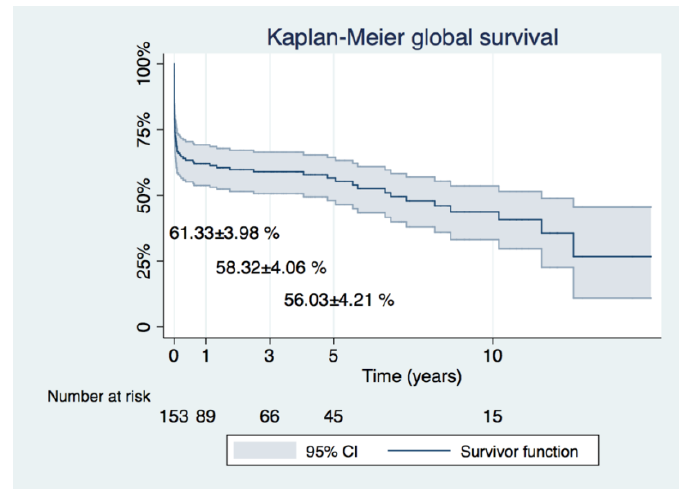
Figure 2. Kaplan–Meier curve depicting global survival of the entire cohort. Table 3. Cox regression analysis for early hazard phase (<30 days).